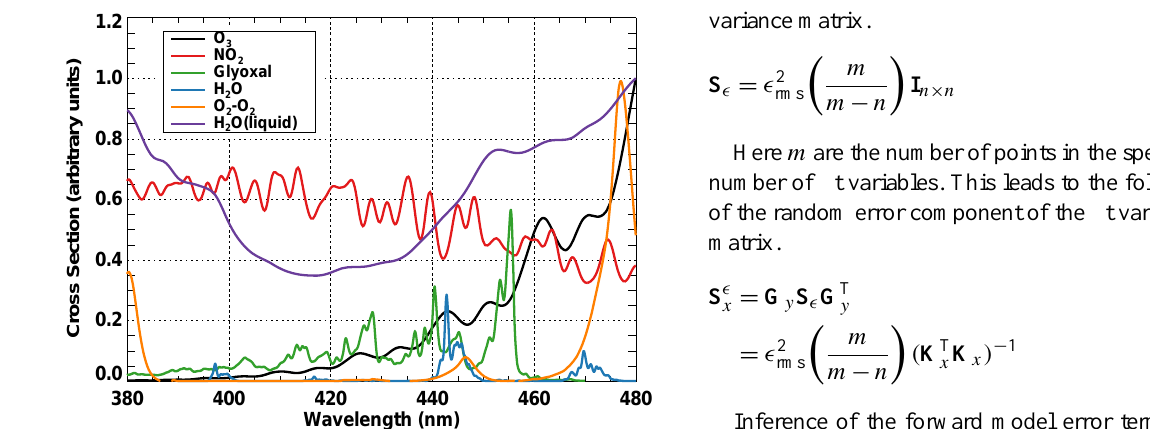
Figure 1. Absorption cross sections for molecules listed in Table 1 degraded to the resolution of OMI. Values have been normalised to order 1 for display